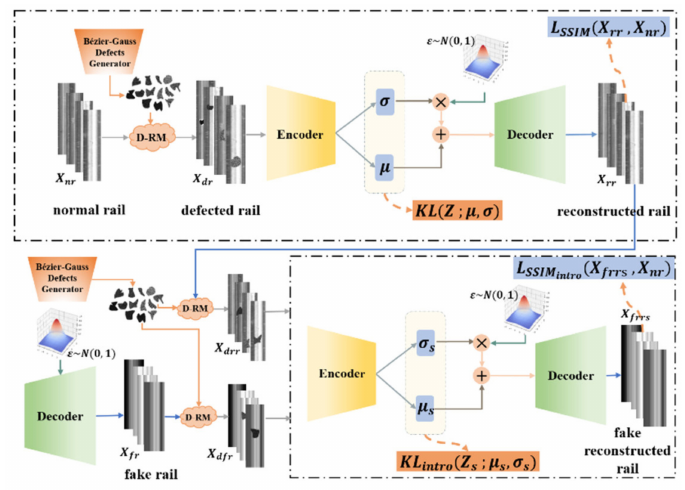
Figure 4. DR-VAE training